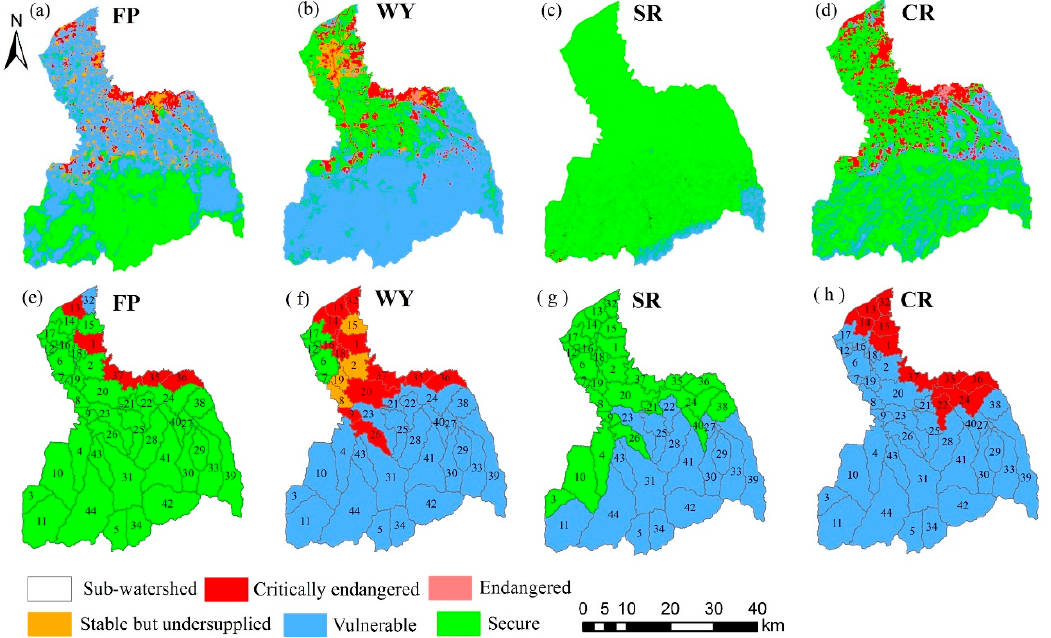
Figure 14. The spatial distribution of supply–demand disk of four ES. The figures ( a - d ) are the supply-demand risk of FP, WY, SR, and CR on grid scale, respectively; The figures ( e - h ) are the supply-demand risk of FP, WY, SR, and CR on sub-watershed scale, respectively.